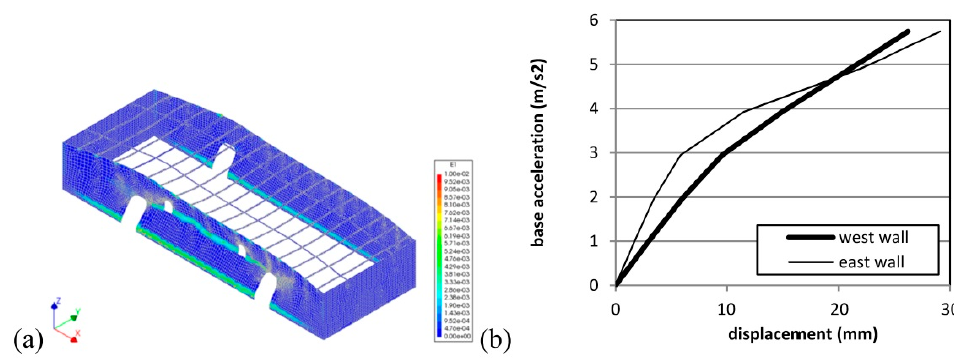
Figure 11. Nonlinear static analysis of the Otaru warehouse: ( a ) principal positive strain distribu- tion contours close to the failure of the structure and ( b ) relations between base acceleration and displacement.